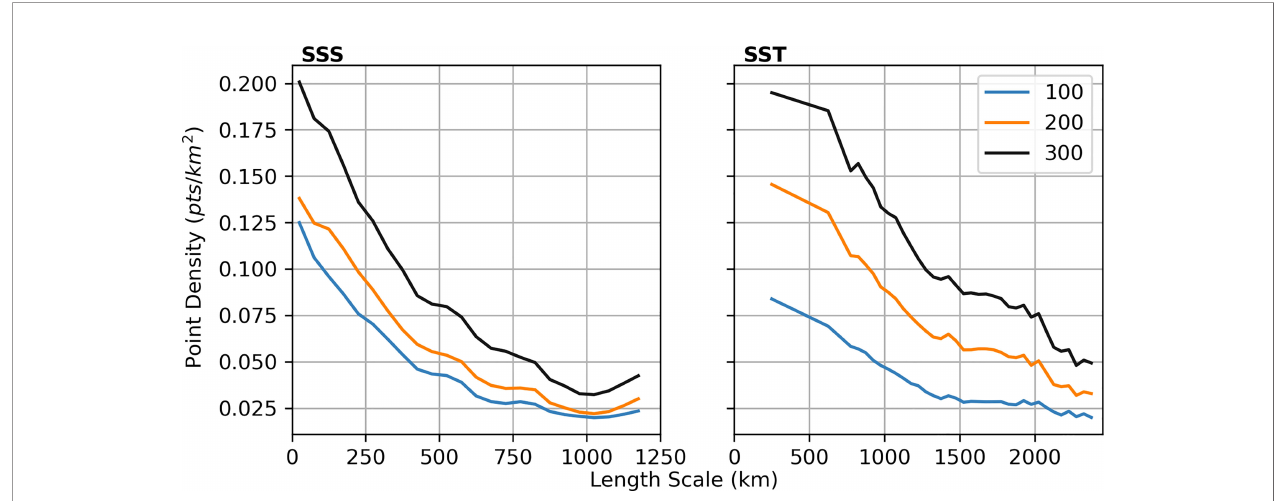
FIGURE 4 | A comparison of length scale and observation density estimates. Observation densities are estimated from outputs of the MSC algorithm for N = 100, 200 and 300 points. The upper bounds on the x-axes are chosen to be the 97.5th percentile of the data, after which the binning process yields much noisier results due to the sparsity of data.